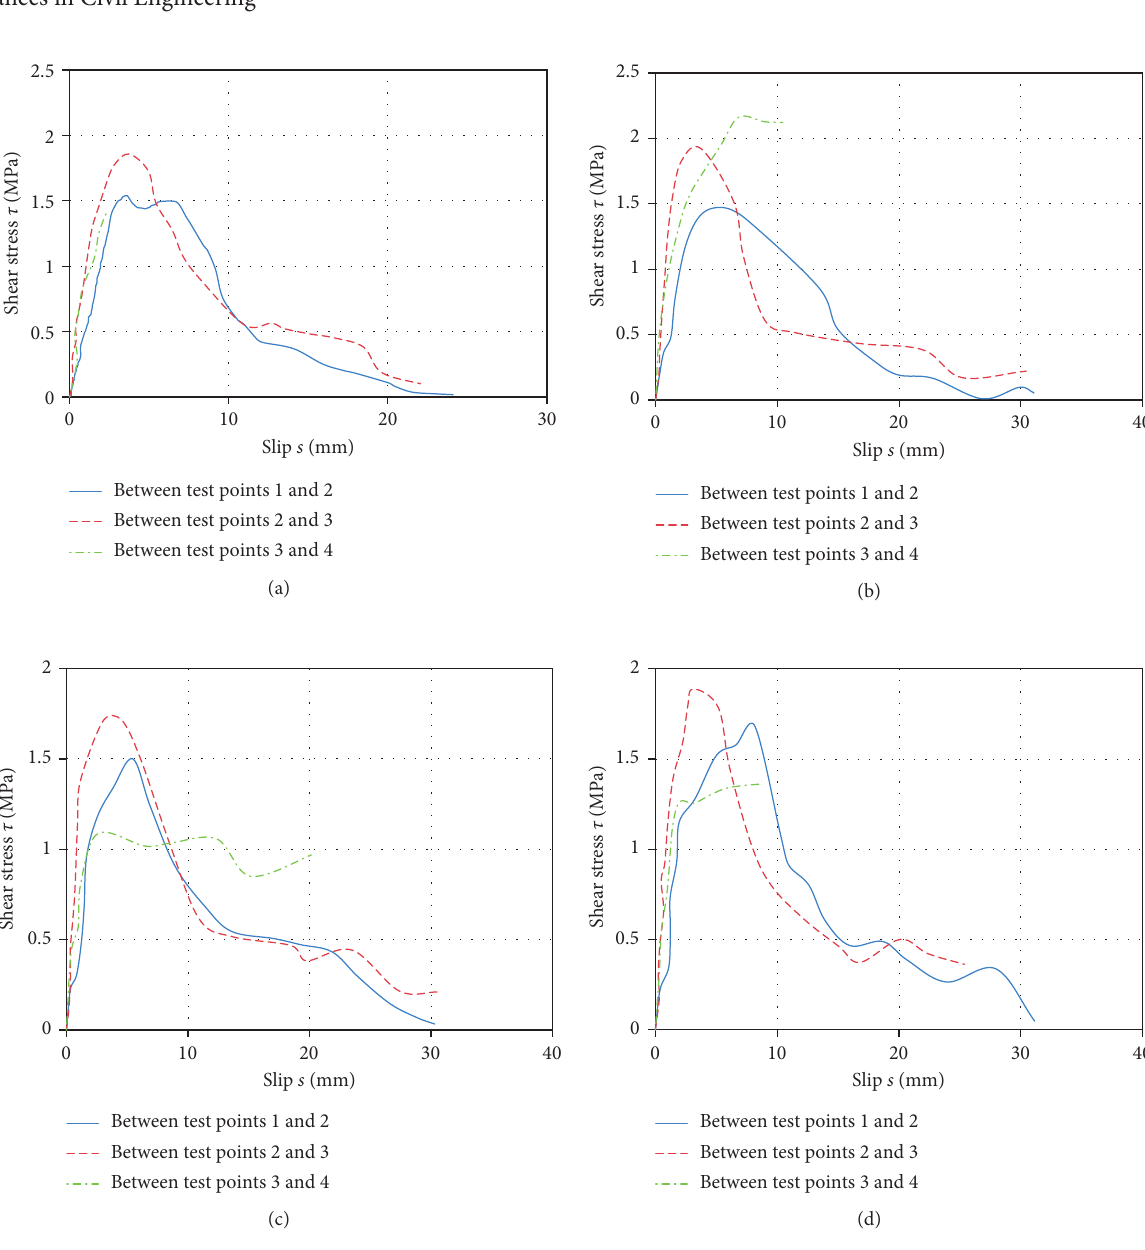
Figure 17: Bond-slip curve of bamboo bolt-modified slurry interface ( τ - s curve). (a) CB-L-2000a. (b) CB-L-2000b. (c) CB-L-3000a. (d) CB-